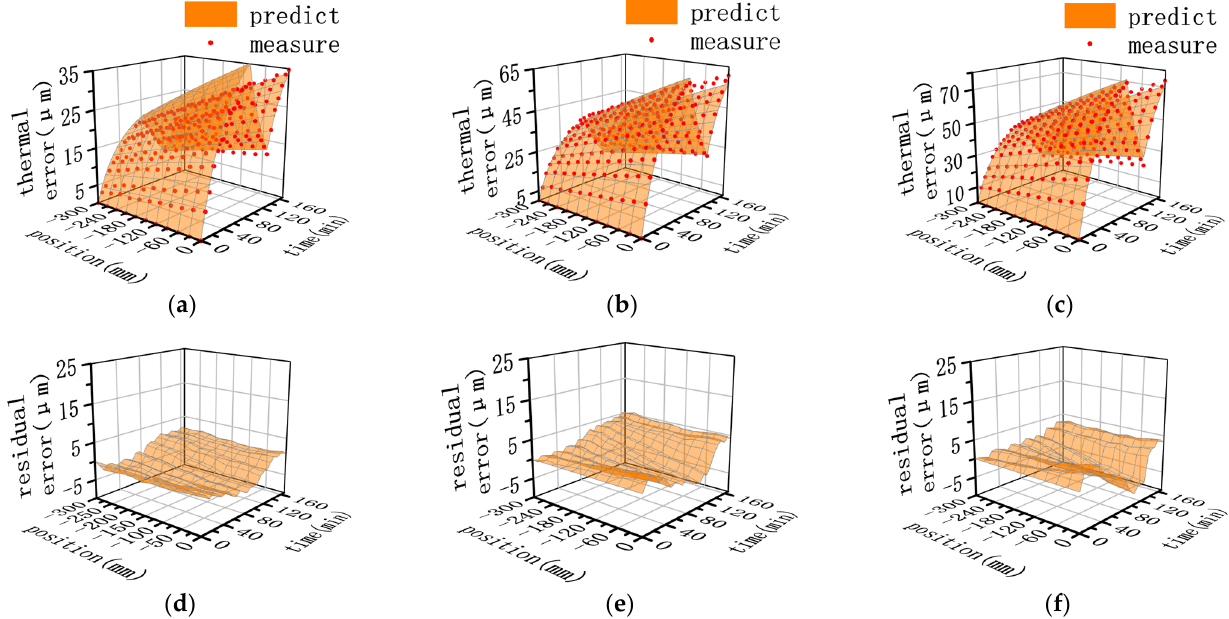
Figure 10. Y-axis error results. ( a ) Measured thermal error in Condition 1. ( b ) Measured thermal error in Condition 2. ( c ) Measured thermal error in Condition 3. ( d ) Residual error in Condition 1. ( e ) Residual error in Condition 2. ( f ) Residual error in Condition 3.